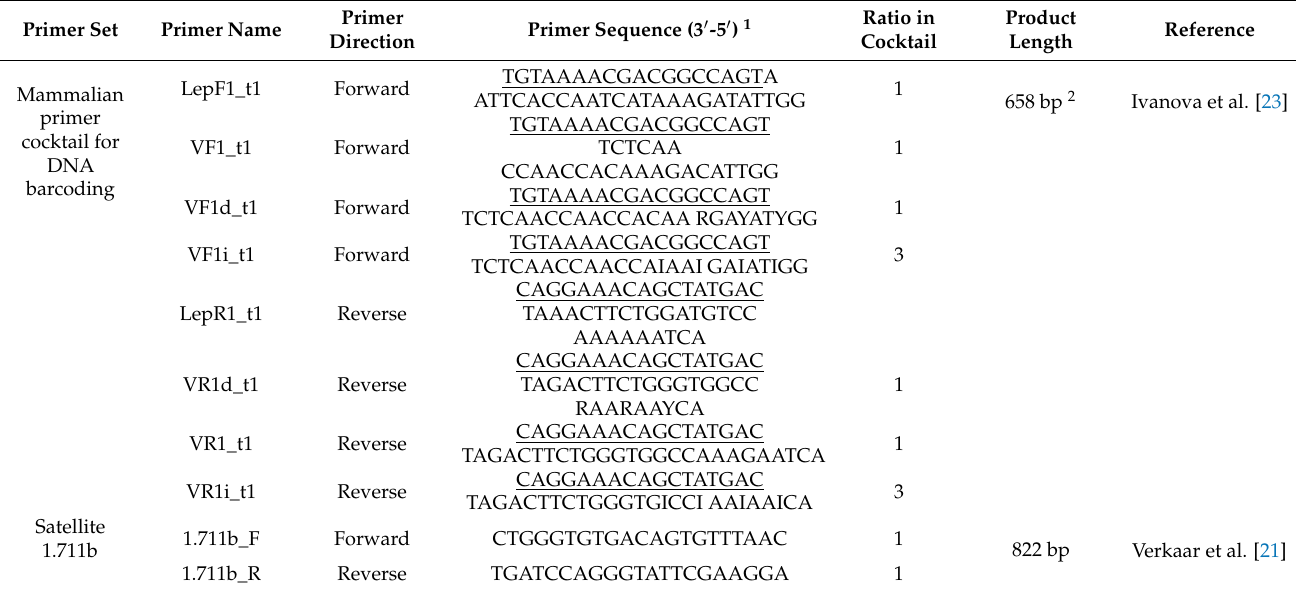
Table 2. PCR primers used in this